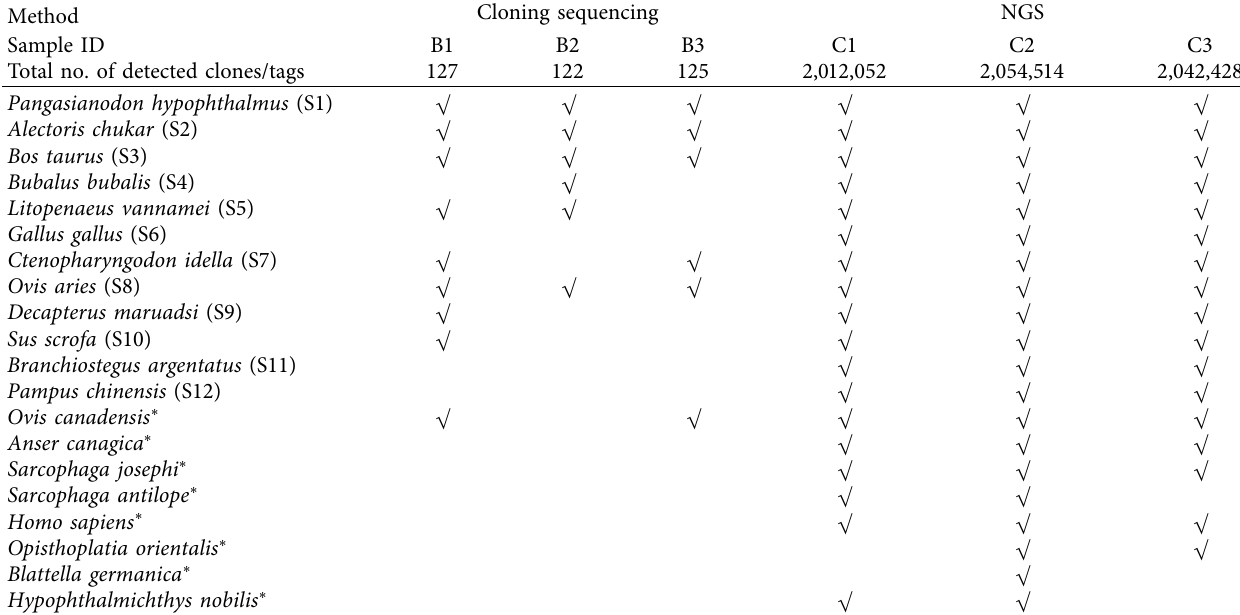
Table 2: Detection of organisms in prescribed meat